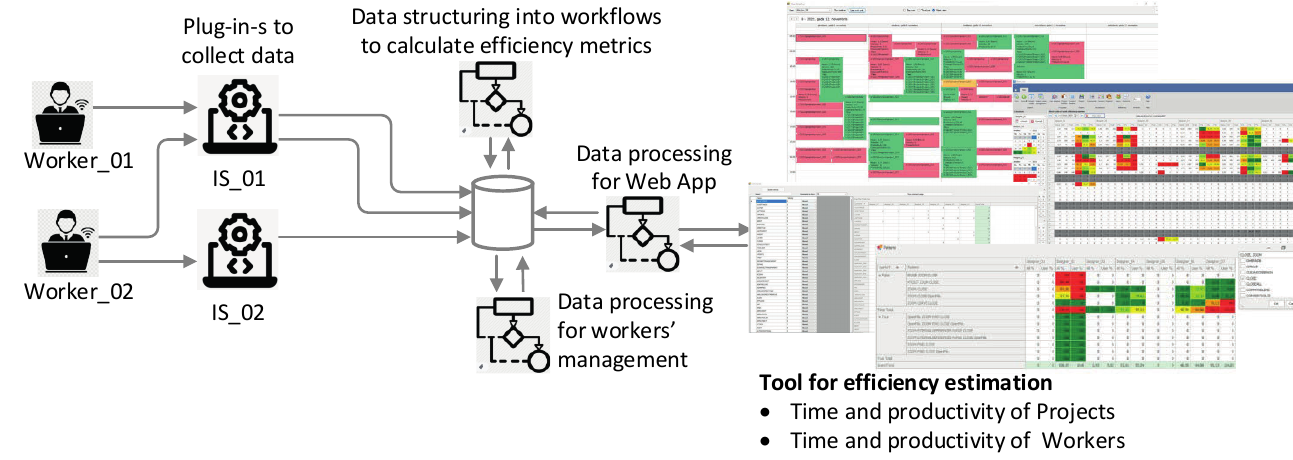
Fig. 1. Conceptual schema of a solution for efficiency estimation of multiple IS users (company workers)